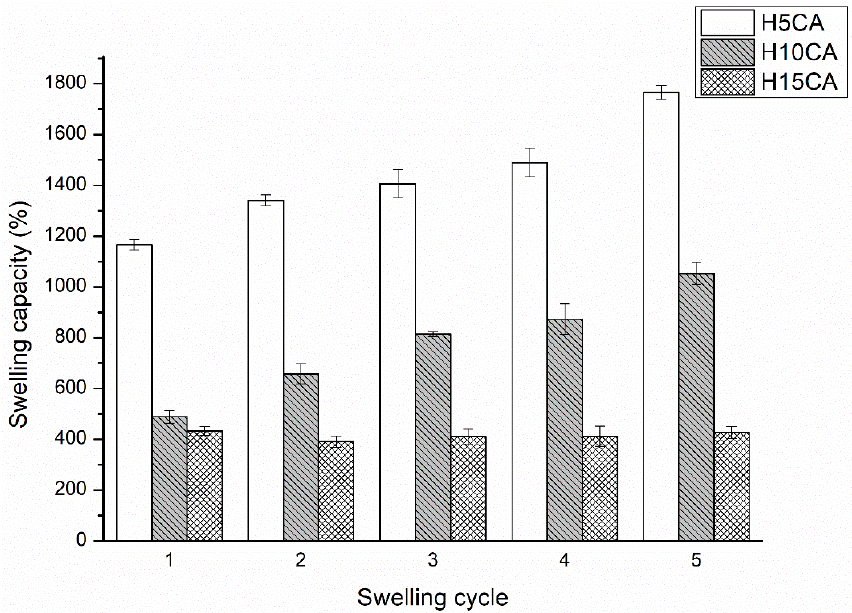
Figure 4. Swelling capacity (%) of the hydrogels H5CA, H10CA and H15CA, following five consecu- tive re-swelling cycles. Data refer to mean values ± SD (n = 3).